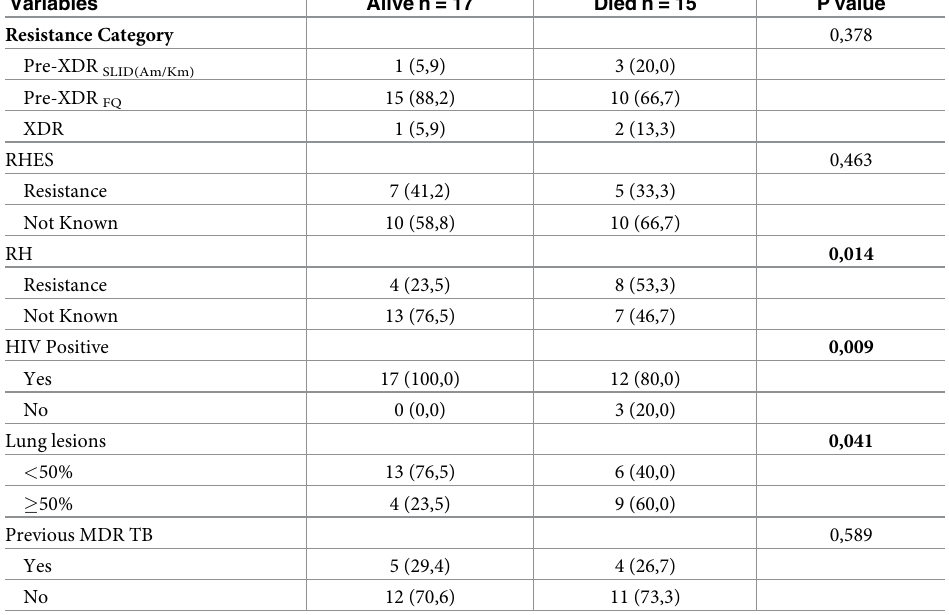
Table 5. General characteristics according to survival